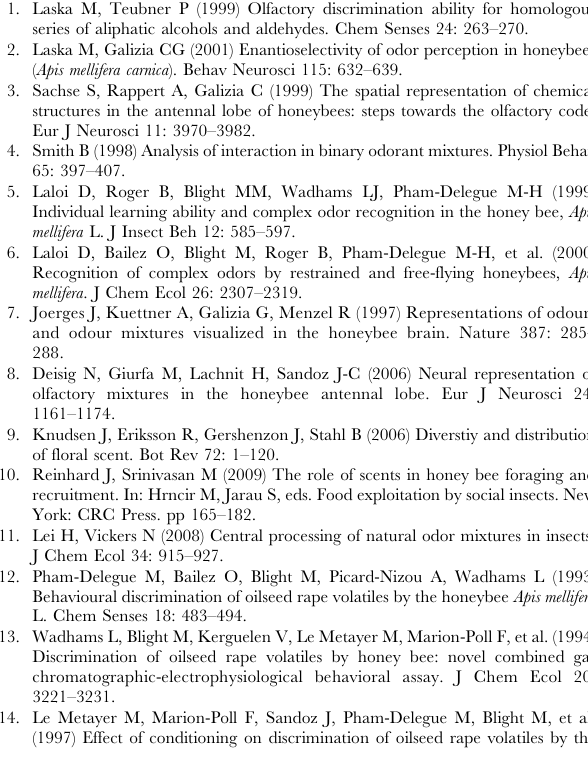
Table S2 Acquisition efficiency of Limonene, Myrcene, and b -